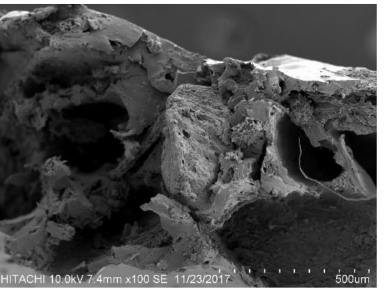
Figure 3. SEM micrograph for 10 wt% thymol in 30BJSP